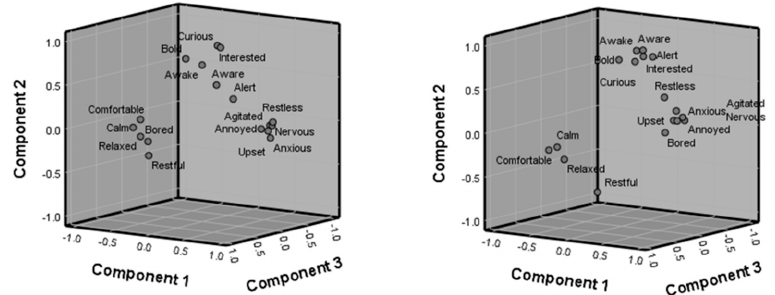
Figure 4. Component plots from a factor analysis using data from two different observers scoring the behavioural expression (psychological welfare) of a male whistling swan over a one-year period. Groupings of descriptors that explain the same amount of variation within the observations appear together.